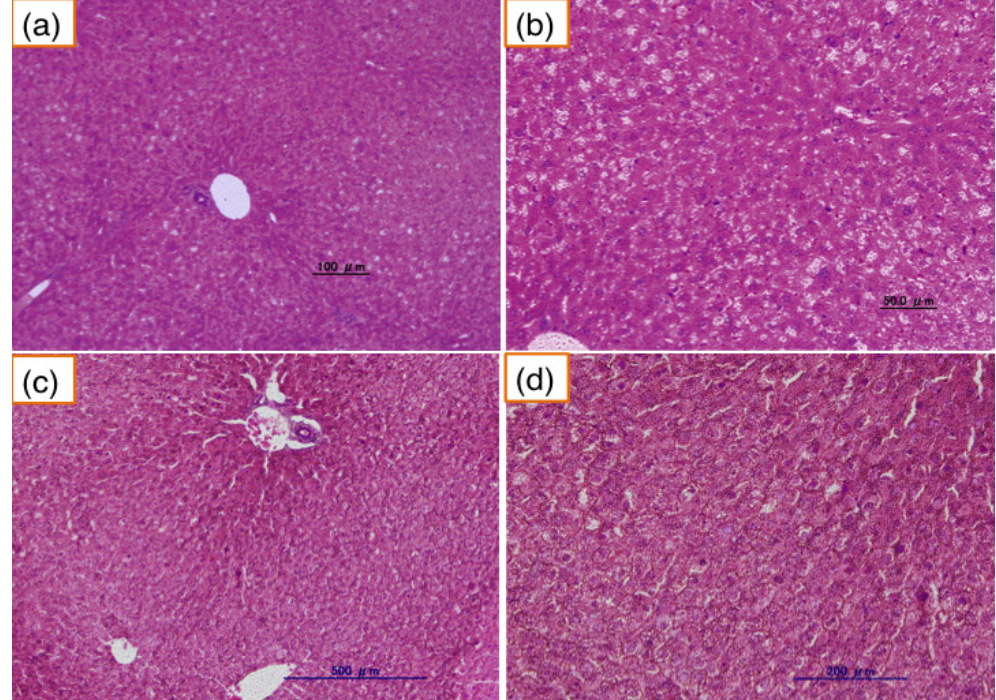
Figure 5. Liver of the normal JW rabbit. ( a ) and ( b ): 12-month-old JW rabbits. ( c ) and ( d ): 35-month-old JW rabbits. ( b ) and ( d ) are enlarged pictures of ( a ) and ( c ), respectively.